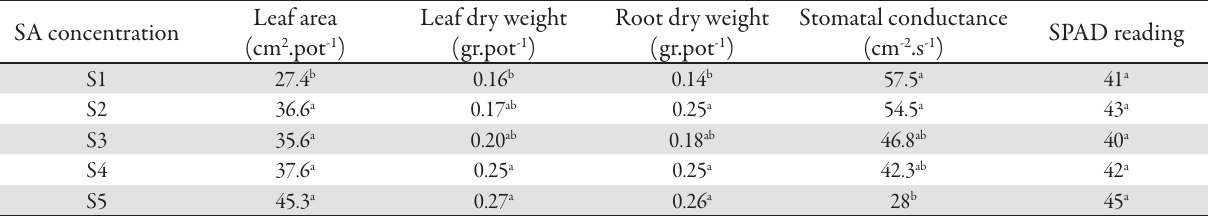
Tab. 2. Effects of various SA concentrations on leaf area, stomatal conductance, leaf and root dry weight, and SPAD reading of cucumber